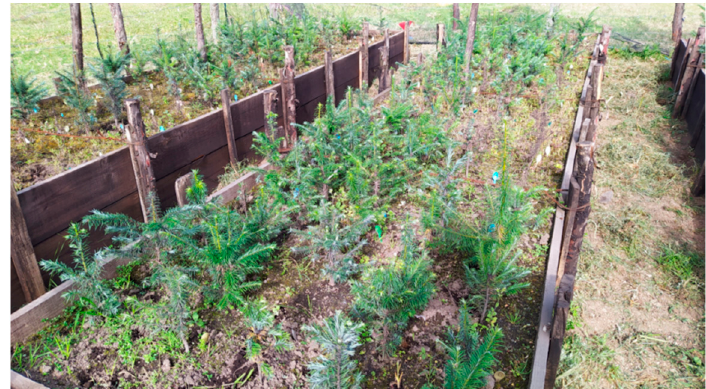
Figure 1. Raised beds of the provenance tests (common gardens) in the site at 2600 m a.s.l., Octo- ber 2020, 15 months after transplantation. Each raised bed contained two complete randomized blocks.